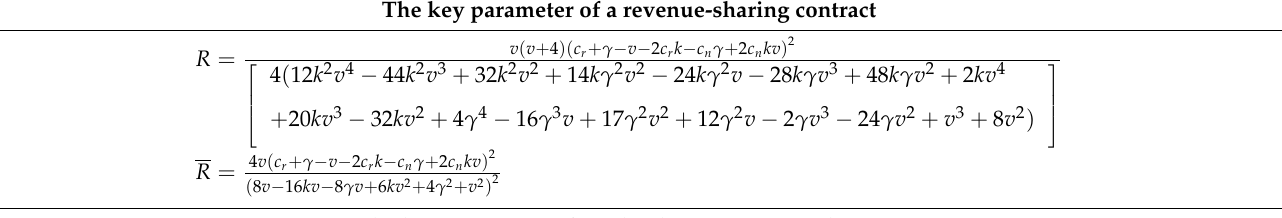
Table 4. Equilibrium decisions of two remedial